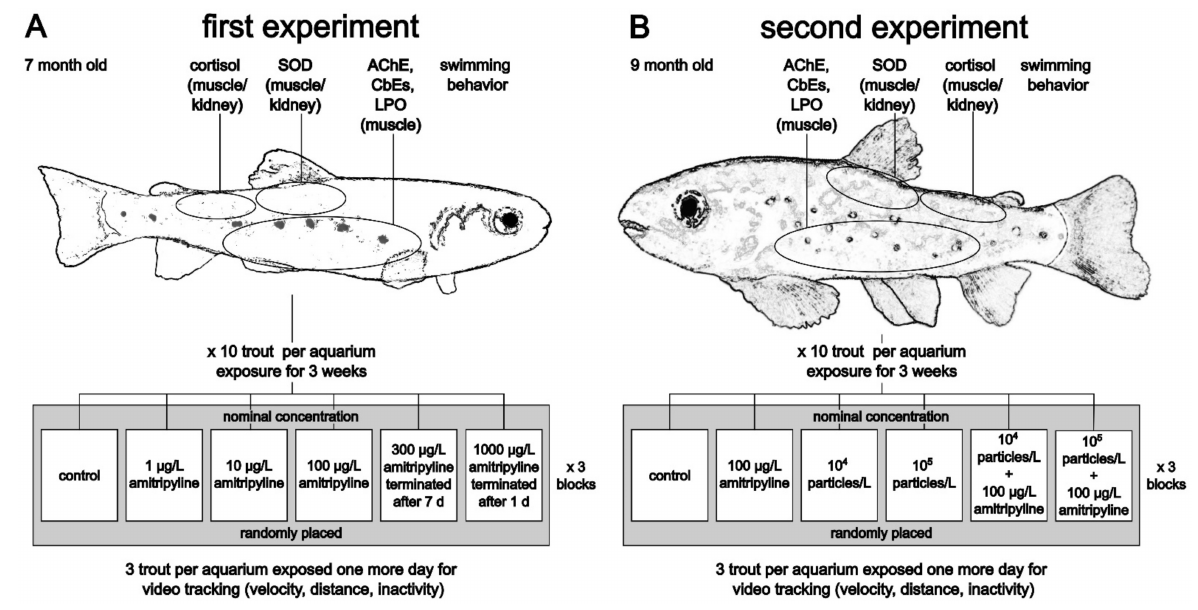
Figure 1. Overview of the experimental designs of the first ( A ) and second ( B ) experiment. Grey boxes indicate one block (SOD: superoxide dismutase; AChE: acetylcholinesterase; CbEs: carboxylesterases; LPO: lipid